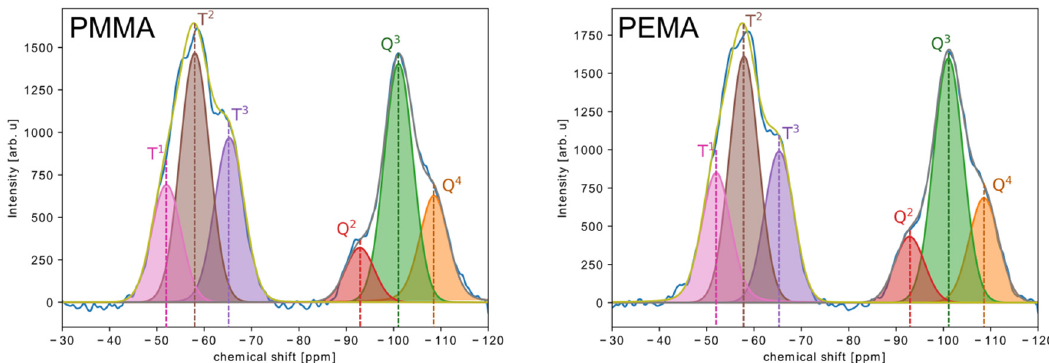
Figure 3. Fitted solid state 29 Si CP/MAS NMR spectra of siloxane-PMMA and siloxane-PEMA monoliths prepared from TEOS, MAPTMS and two acrylates: methyl methacrylate (MMA) and ethyl methacrylate (EMA). After synthesis, sols were treated thermally for 1 h at 60 ° C then 1 h at 180 ° C to obtain monoliths. The experimental curve (blue line), fitted curve (yellow line) and individual component peaks used for fitting the experimental curve. Experimental curves were fitted using three component peaks described by pseudo-Voigt functions, using a non-linear least squares method a . An estimate of a 1% error in the determination of the fraction of each component peak can be predicted. Absolute and relative proportions of T and Q species obtained by deconvolution of spectra are given in Table 3. a. https://docs.scipy.org/doc/scipy/reference/generated/scipy.optimize.curve_fit.html.